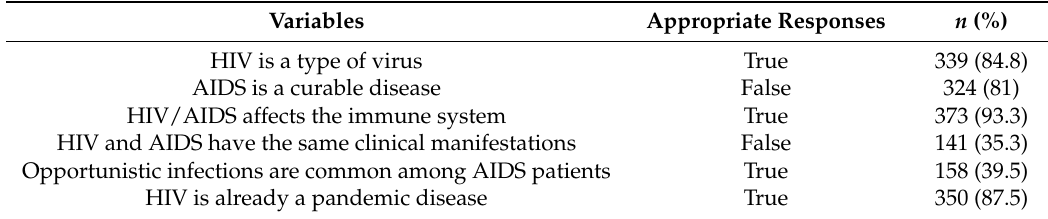
Table 2. Knowledge about HIV and AIDS among 400 undergraduate students enrolled in the study.